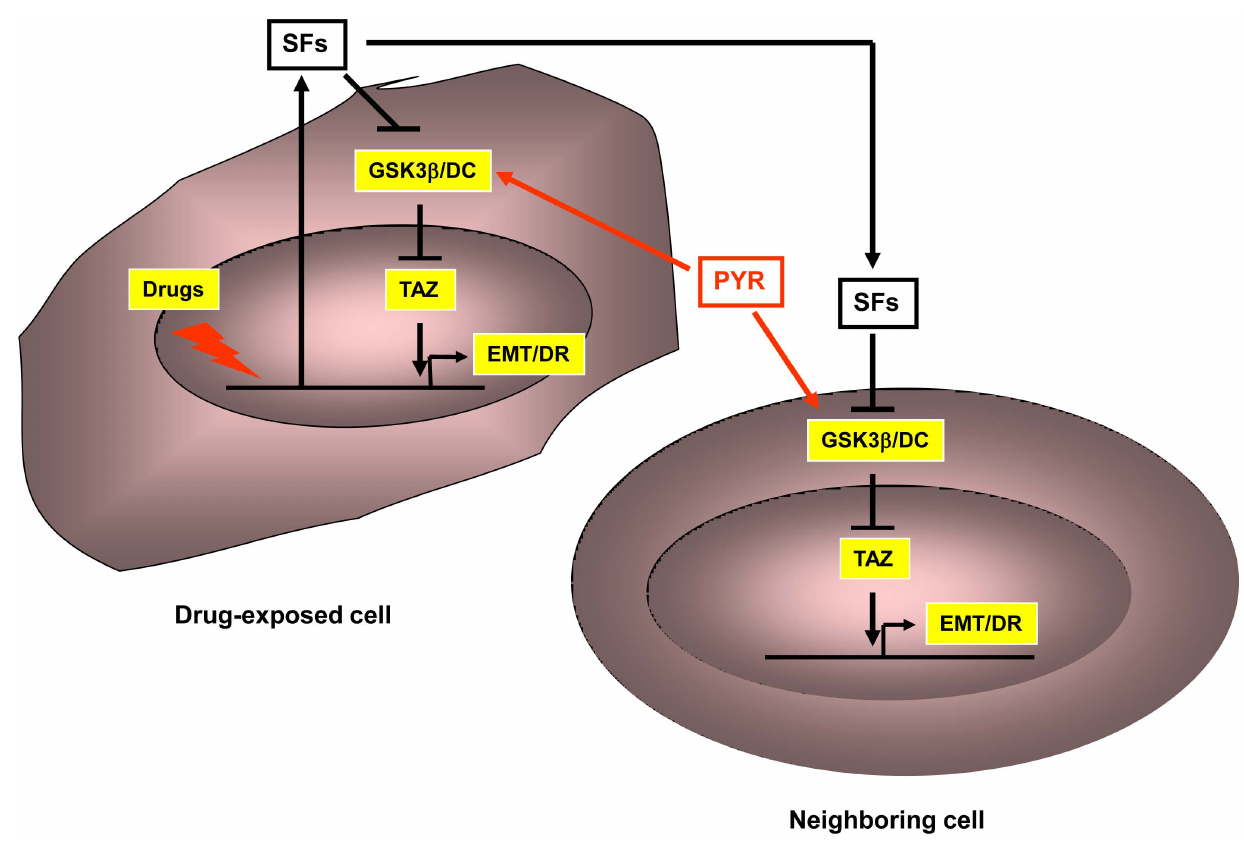
Figure 7. Schematic model depicting nuclear regulation of the Hippo pathway in drug-affected and neighboring cells. Exposure to certain drugs affecting DNA or chromatin results in enhanced expression of secreted growth factors and cytokines. These secreted factors (SFs) may in turn signal in autocrine/paracrine manner for activation of Akt and inhibition of GSK3 beta associated degradation complex (GSK3 b /DC) resulting in stabilization of TAZ oncogene. Consequently, expression of EMT genes is enhanced, leading to increased cell migration and drug resistance (DR) in both drug affected and neighboring cells. These processes can be overcome by using pyrvinium (PYR), a pharmacological activator of GSK3 beta associated degradation